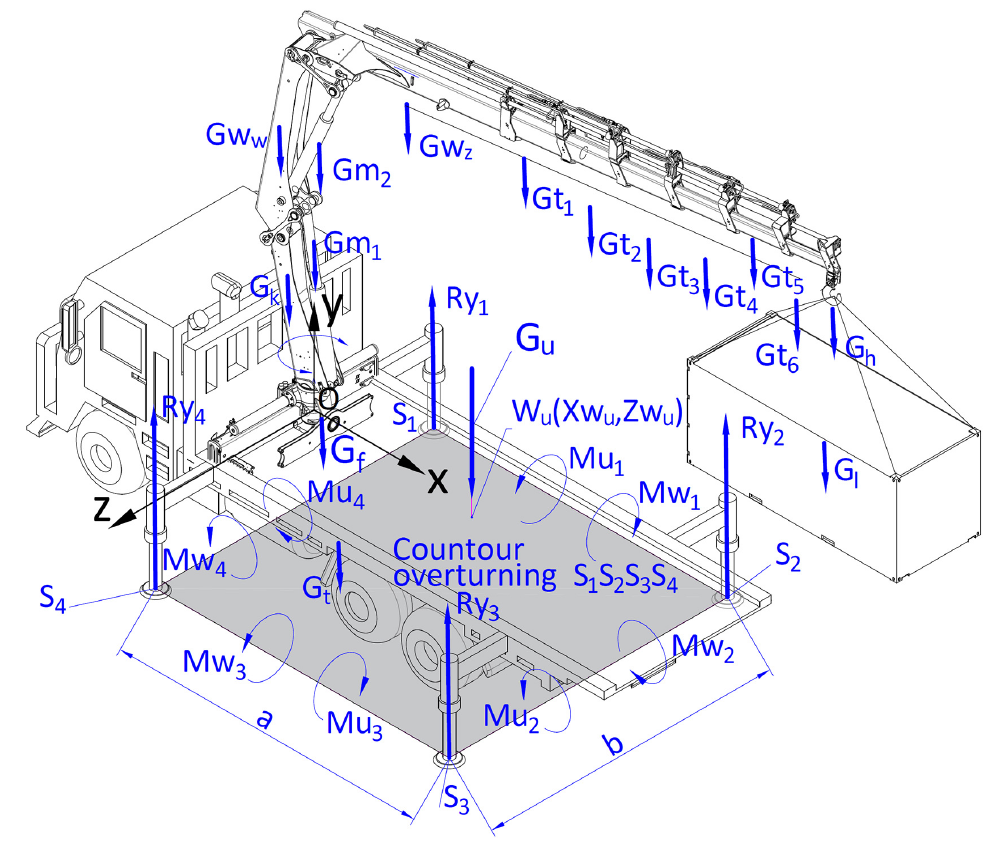
Figure 1. Calculation diagram for forces and torques acting on the crane outrigger system, where: G u — total weight of the crane system; G f —total weight of the truck with the outrigger system; G b —weight of the crane base; G k —weight of the rotating column; Gw w —weight of the inner arm; Gw z —weight of the outer arm; Gm 1 , Gm 2 —weights of the hydraulic actuators; Gt 1 , Gt 2 , ..., Gt 6 —weights of the arms of a six-member crane boom; G h —hook weight; G l —cargo weight; a and b —spacing of the crane